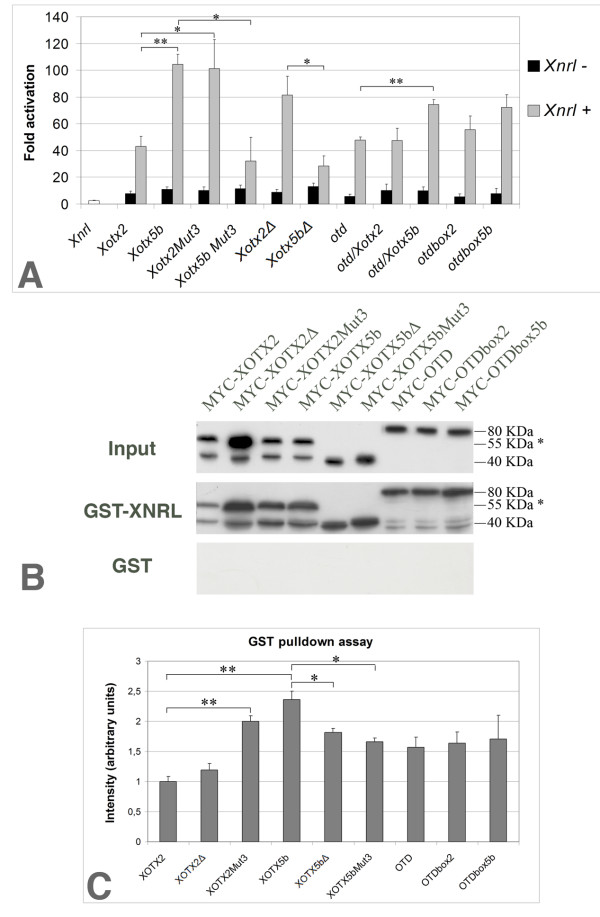
XOTX2 and XOTX5b differentially synergize with XNRL to activate the rhodopsin promoter and differentially interact in vitro with XNRL. (a) Results of rhodopsin promoter cell transfection assays with several Xotx/otd constructs (with or without Xnrl). Error bars indicate the standard error of the mean. (b) GST-pull down assays compare the interaction of MYC-XOTX/OTD fusion proteins to GST-XNRL or GST alone. The band indicated by an asterisk corresponds to a higher molecular weight (55 kDa) than the one expected for XOTX proteins (41 kDa) and may result from post-translational modification; this needs further investigation. (c) Results of two of these experiments, analyzed by Image J, were statistically processed; columns show the ratio of the retained MYC-tagged proteins relative to their respective input, normalized with respect to the MYC-XOTX2 retained/input ratio. Error bars indicate the standard deviation. The p-value was calculated by bilateral Student's t-test. Asterisks in histograms show statistically significant differences only for more relevant comparisons (*p < 0.05, **p <0.01). (see Additional files 12 and 13 for the full data set).